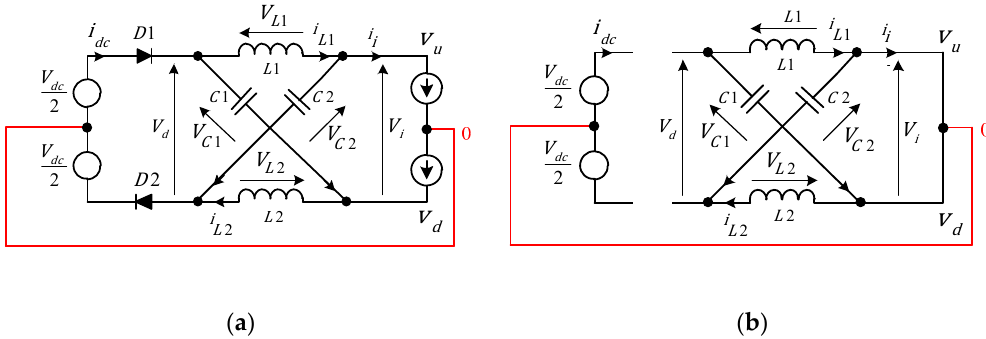
Figure 6. Simplified equivalent circuit for evaluating conditions: ( a ) NST state; ( b ) ST state.